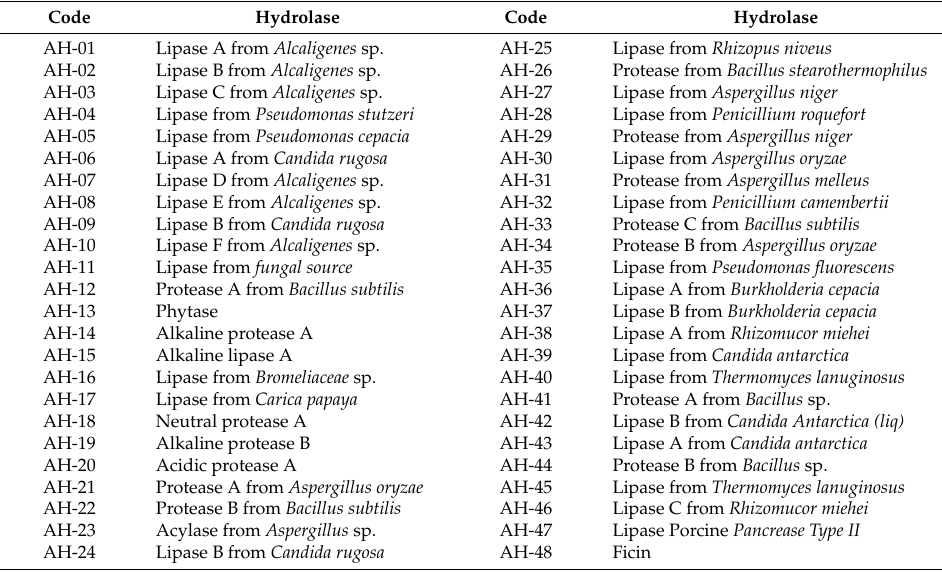
Table 6. Hydrolase enzymes used to screen against ( rac )- 4